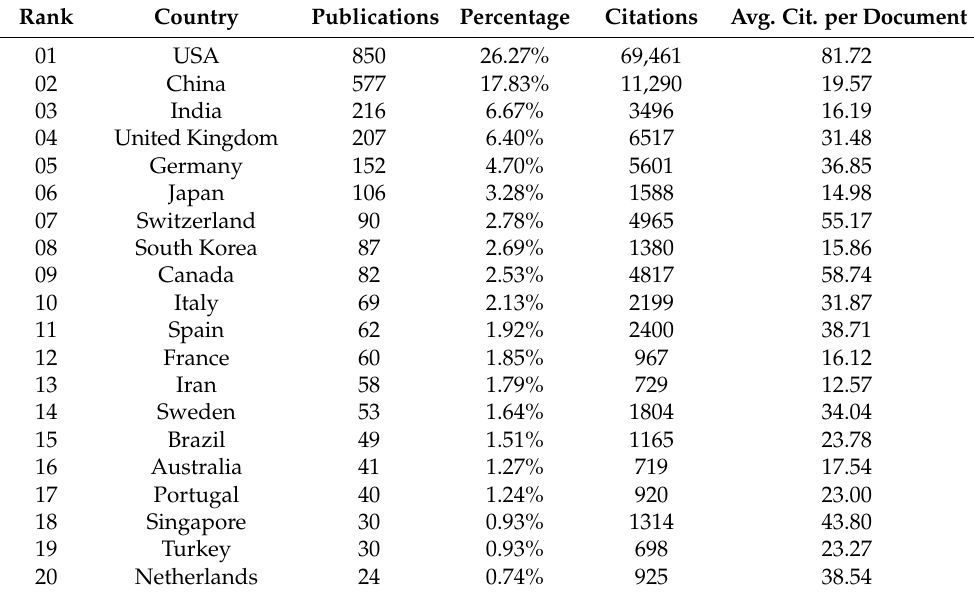
Table 4. Overview of the countries with the most publications ( n =